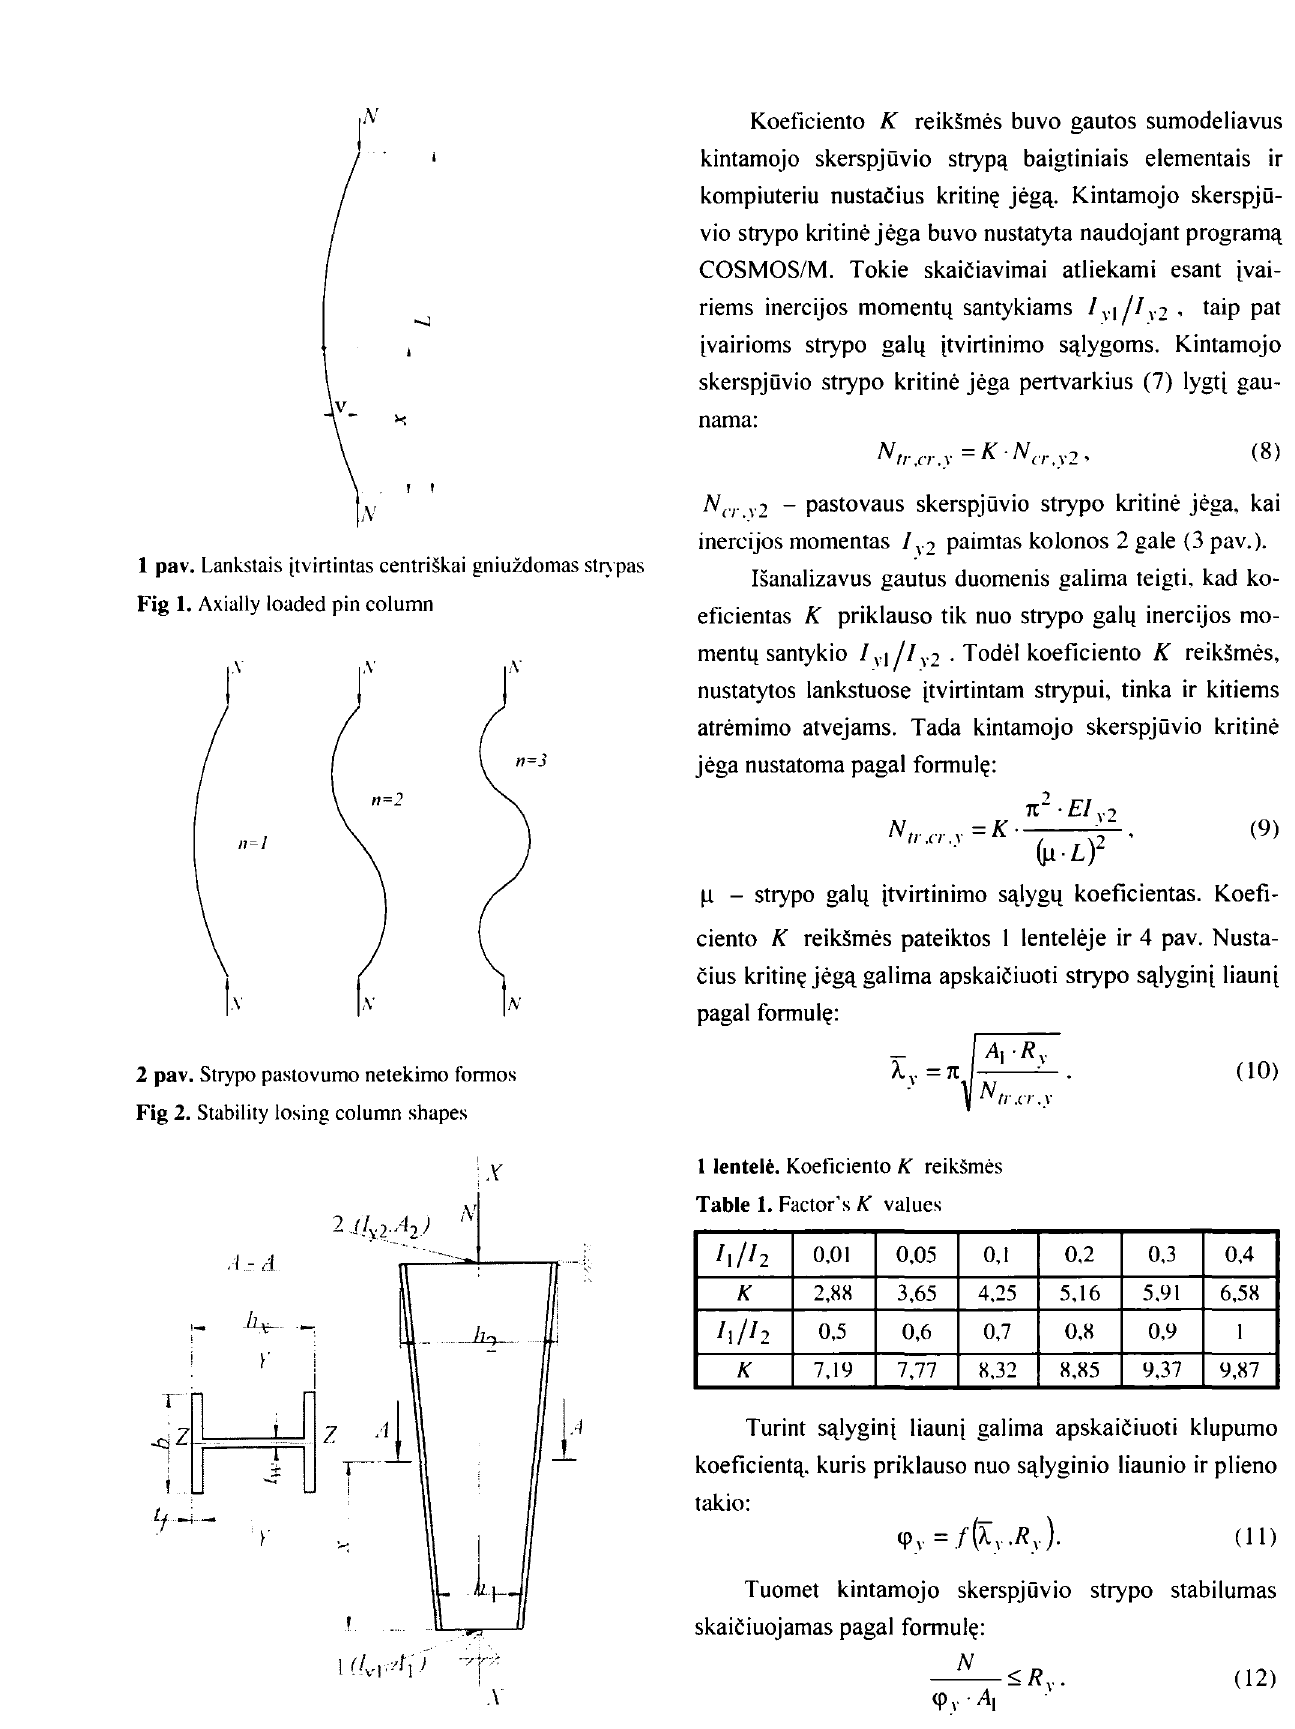
Fig 3. Axially loaded tapered column